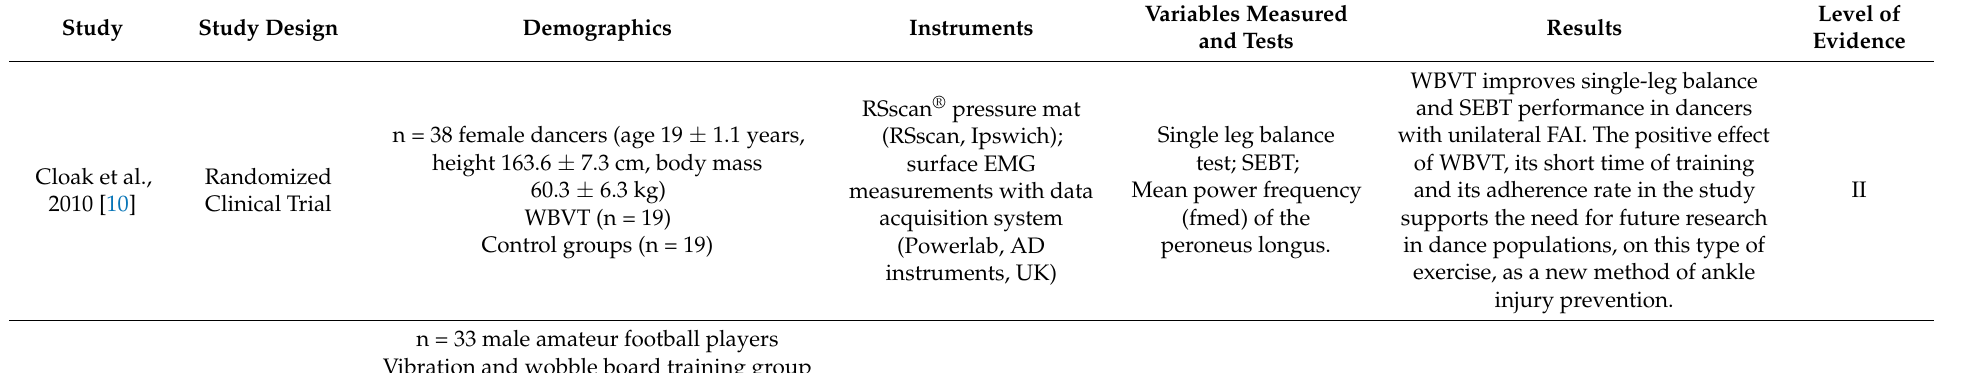
Table 2. Table of the characteristics of selected